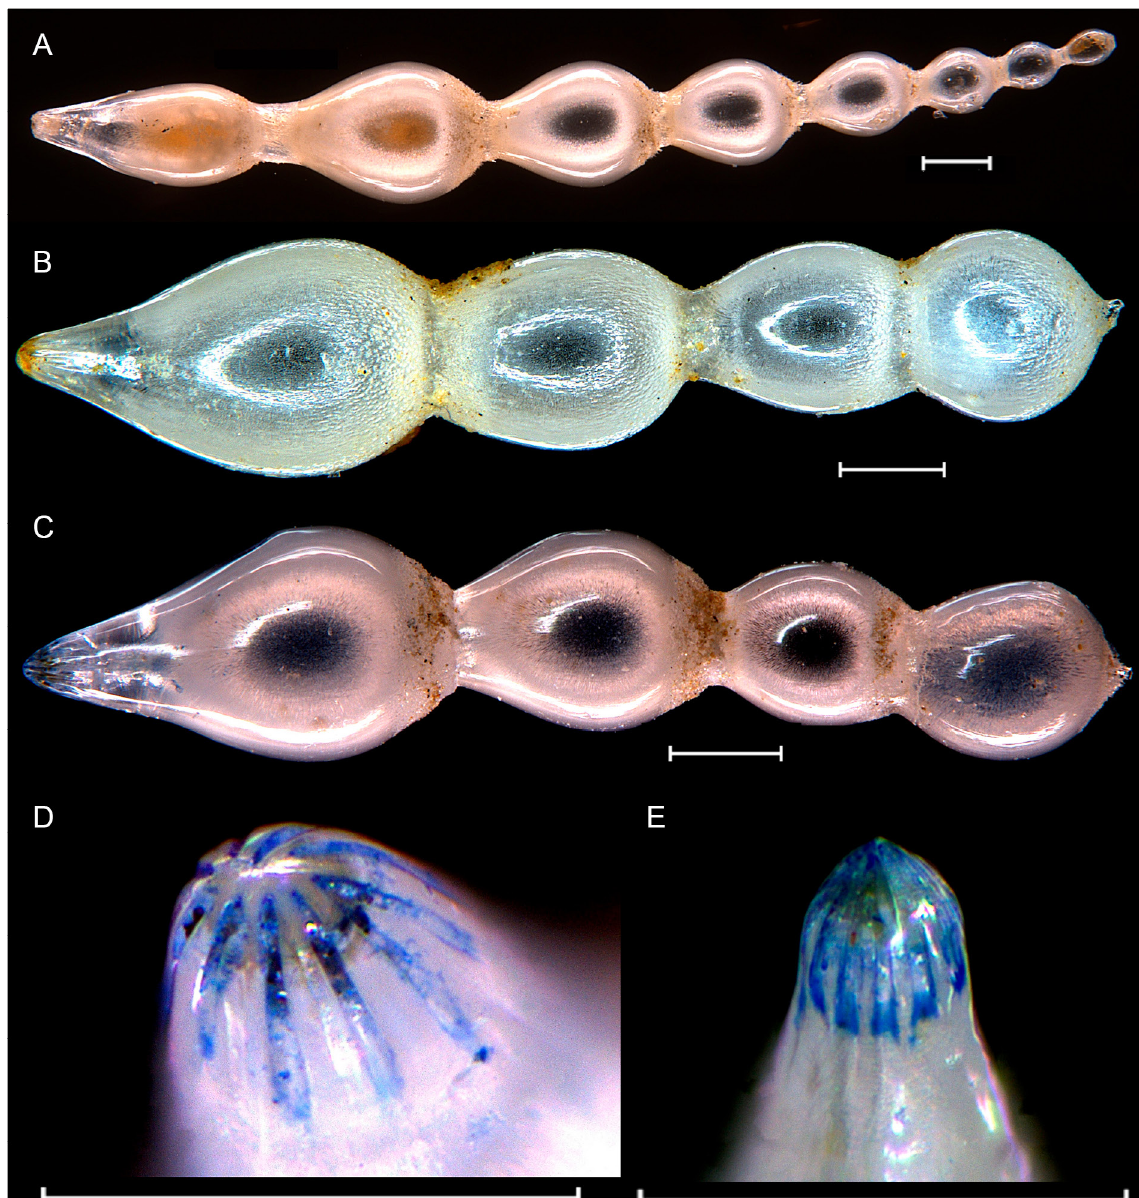
Fig. 11. Grigelis guttifera (d’Orbigny, 1846) comb. nov. A . Microsphere (BIOICE 3522, IINH 40126), base of chambers hispid; initial end missing. B, D . Megalosphere (BIOICE 2708, IINH 40107), side view, base of chambers mostly with knobs and faint striations (A) and aperture (D) stained with indigo blue. C . Megalosphere (BIOICE 2853, IINH 40236b), base of chambers hispid and with knobs. E . Megalosphere (BIOICE 3166, IINH 40116), aperture stained with indigo blue. Light source combination of incident light and dark field. Scale bars = 0.25